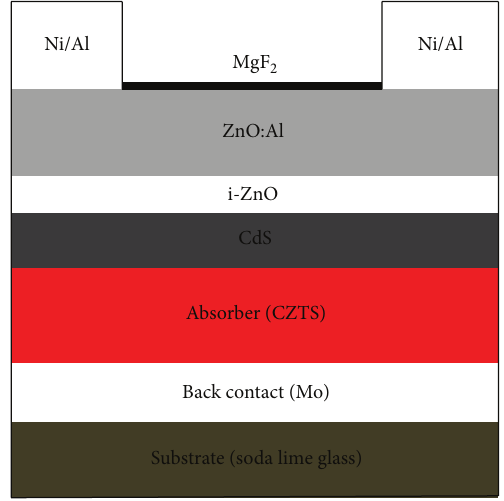
Figure 1: Structure of CZTS based solar cells.